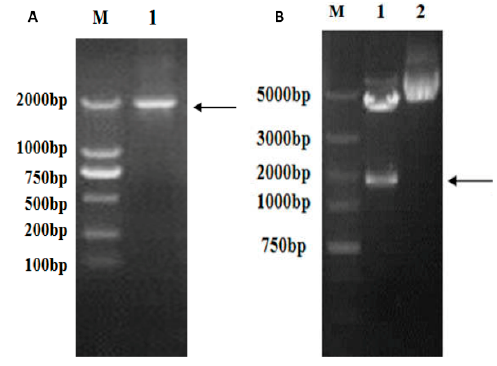
Figure 2. Verification of the vp5 gene. ( A ) RT-PCR amplification of vp5 : lane M, DNA marker; lane 1,